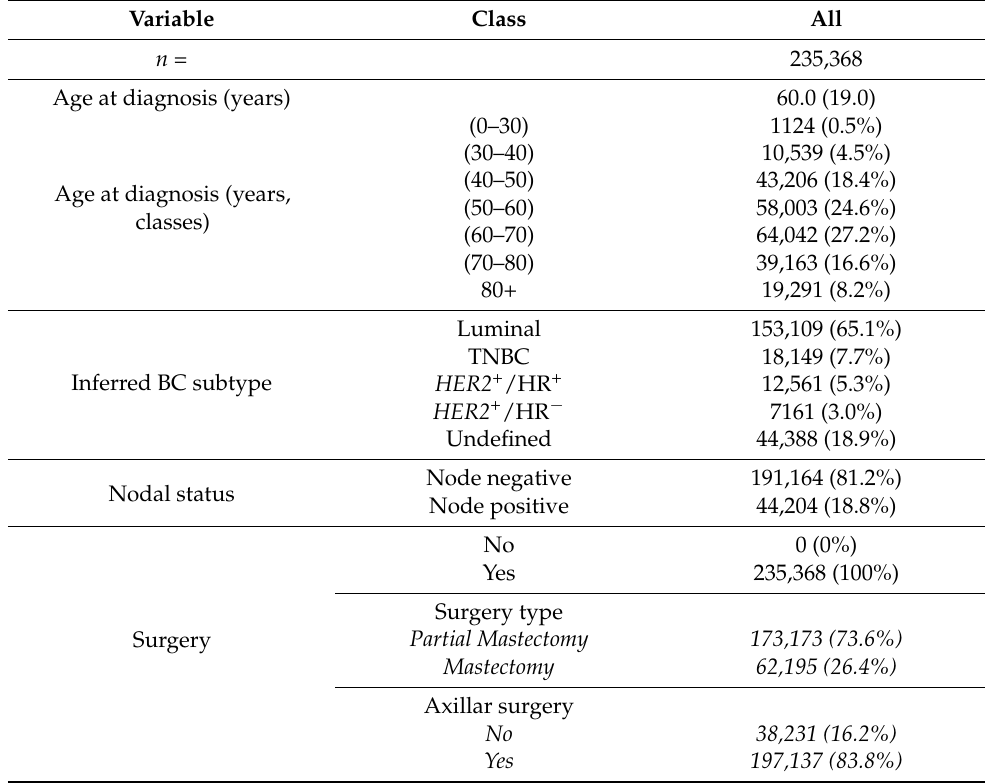
Table 1. Baseline characteristics of the French Early Breast Cancer